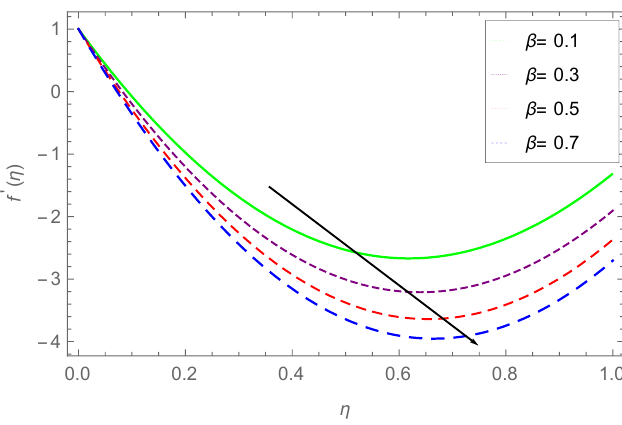
Figure 2. Impact of β on f (cid:48) ( η ) , when γ 1 = 0.2, St = 0.6, Gm = 0.8, Gr = 0.7, M = 0.8.